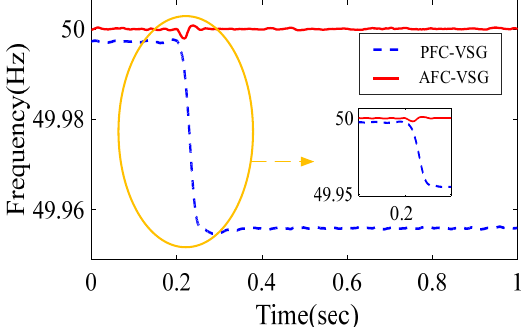
Figure 9. Frequency regulation ability between the PFC-VSG and the AFC-VSG under the sudden load increase condition.